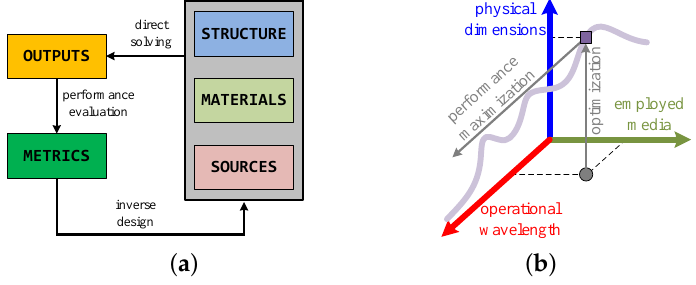
Figure 1. ( a ) Schematic diagram of the forward and inverse design of an electromagnetic system (reproduced with permission from [7]); ( b ) illustrative description of the optimization process sweeping the model